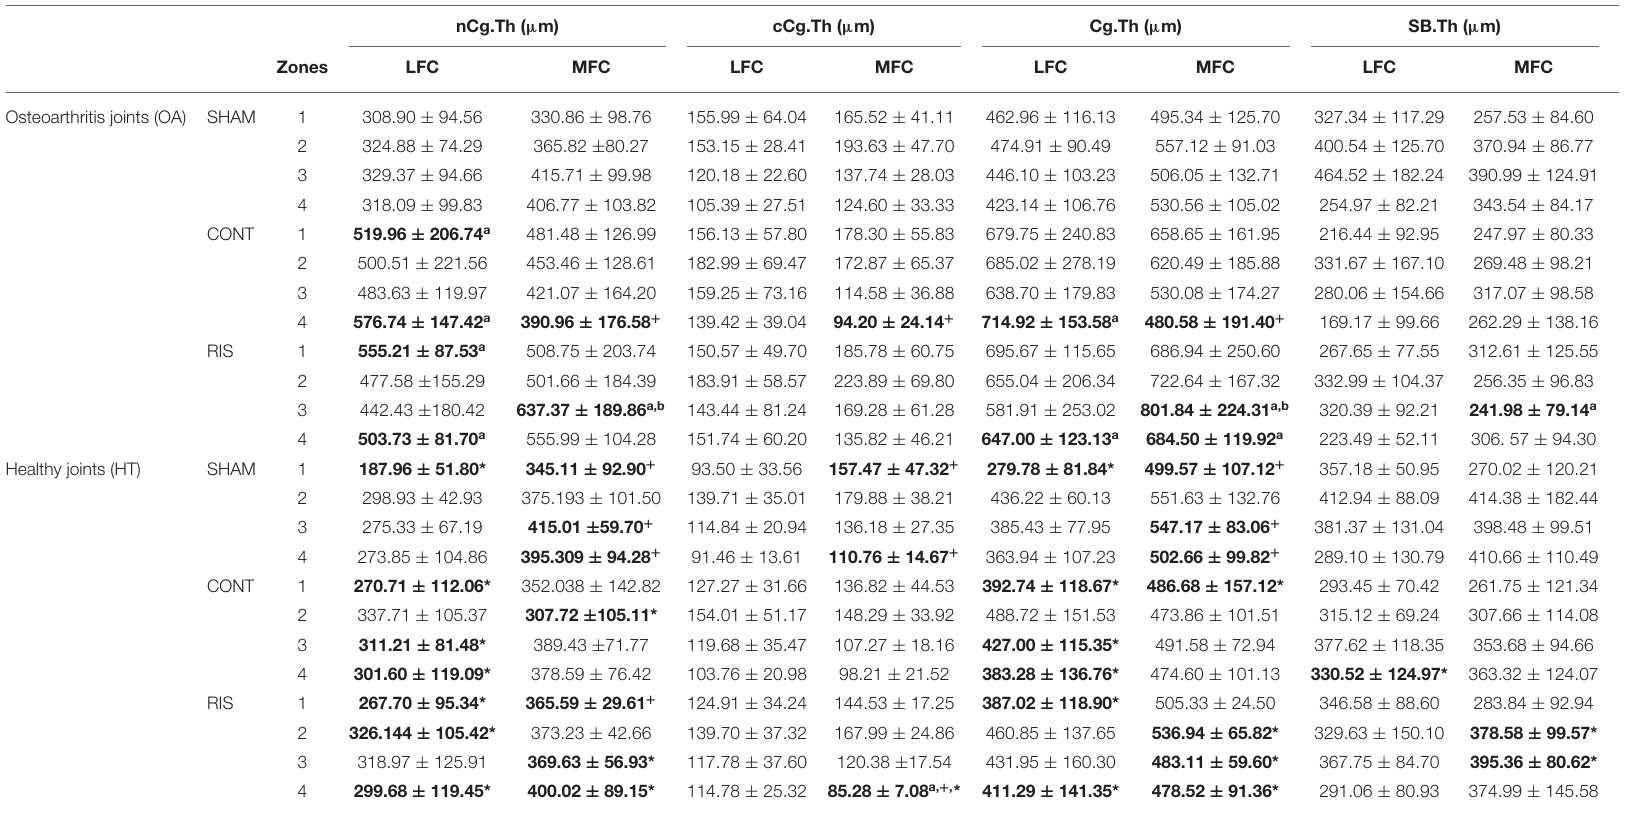
TABLE 1 | Stereologic histomorphometric analysis of femoral